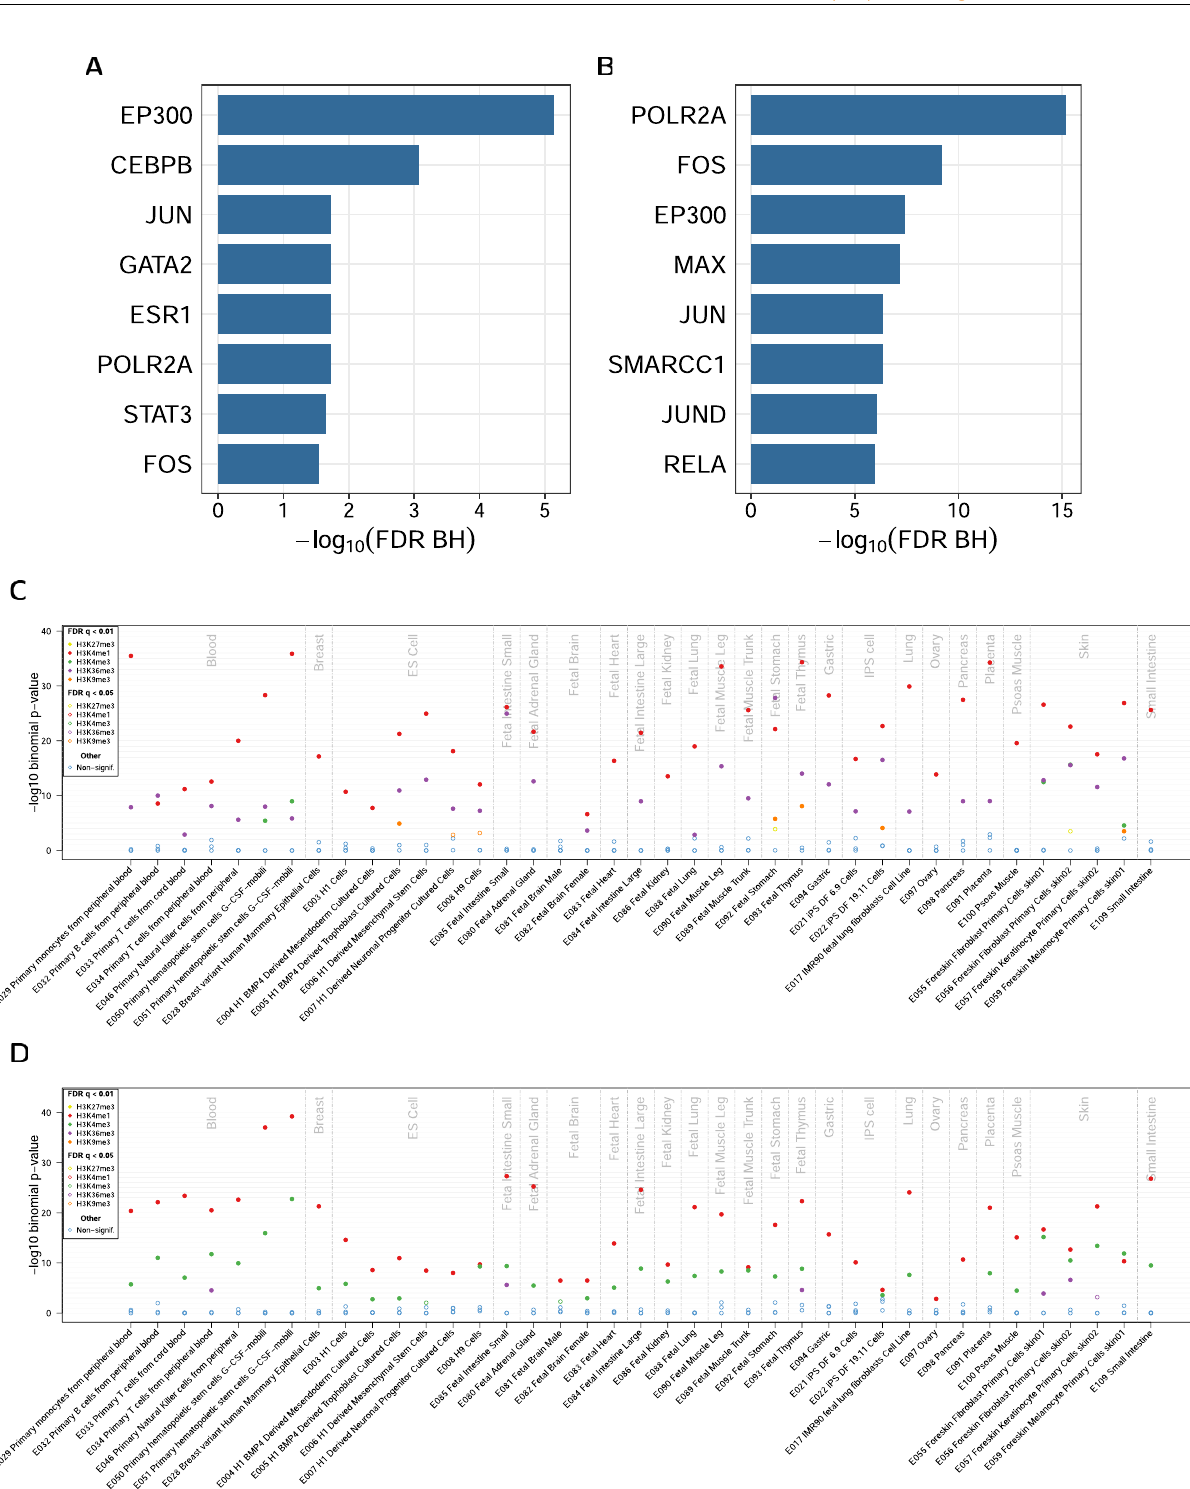
Fig. 4 Enrichment in transcription factor binding sites and histone marks. Enrichment analysis of CpG sites (CpGs) signi fi cantly associated with estimated glomerular fi ltration rate (eGFR) ( A ) and urinary albumin-to-creatinine ratio (UACR) ( B ) for mapping into regions containing speci fi c transcription factor binding sites at Benjamini-Hochberg FDR < 0.05. Panels ( C ) and ( D ) show the corresponding results for mapping into histone marks. In these panels, the Y -axis show the − log 10 ( P -value) from a binomial test comparing the expected and observed numbers of signi fi cant CpGs that map into the binding site regions for a given target. On the X -axis, the results with an FDR < 0.05 of 169 evaluated transcription factors are listed in alphabetical order. Enrichment testing was carried out using permutation with matching for genomic localization when sampling from the